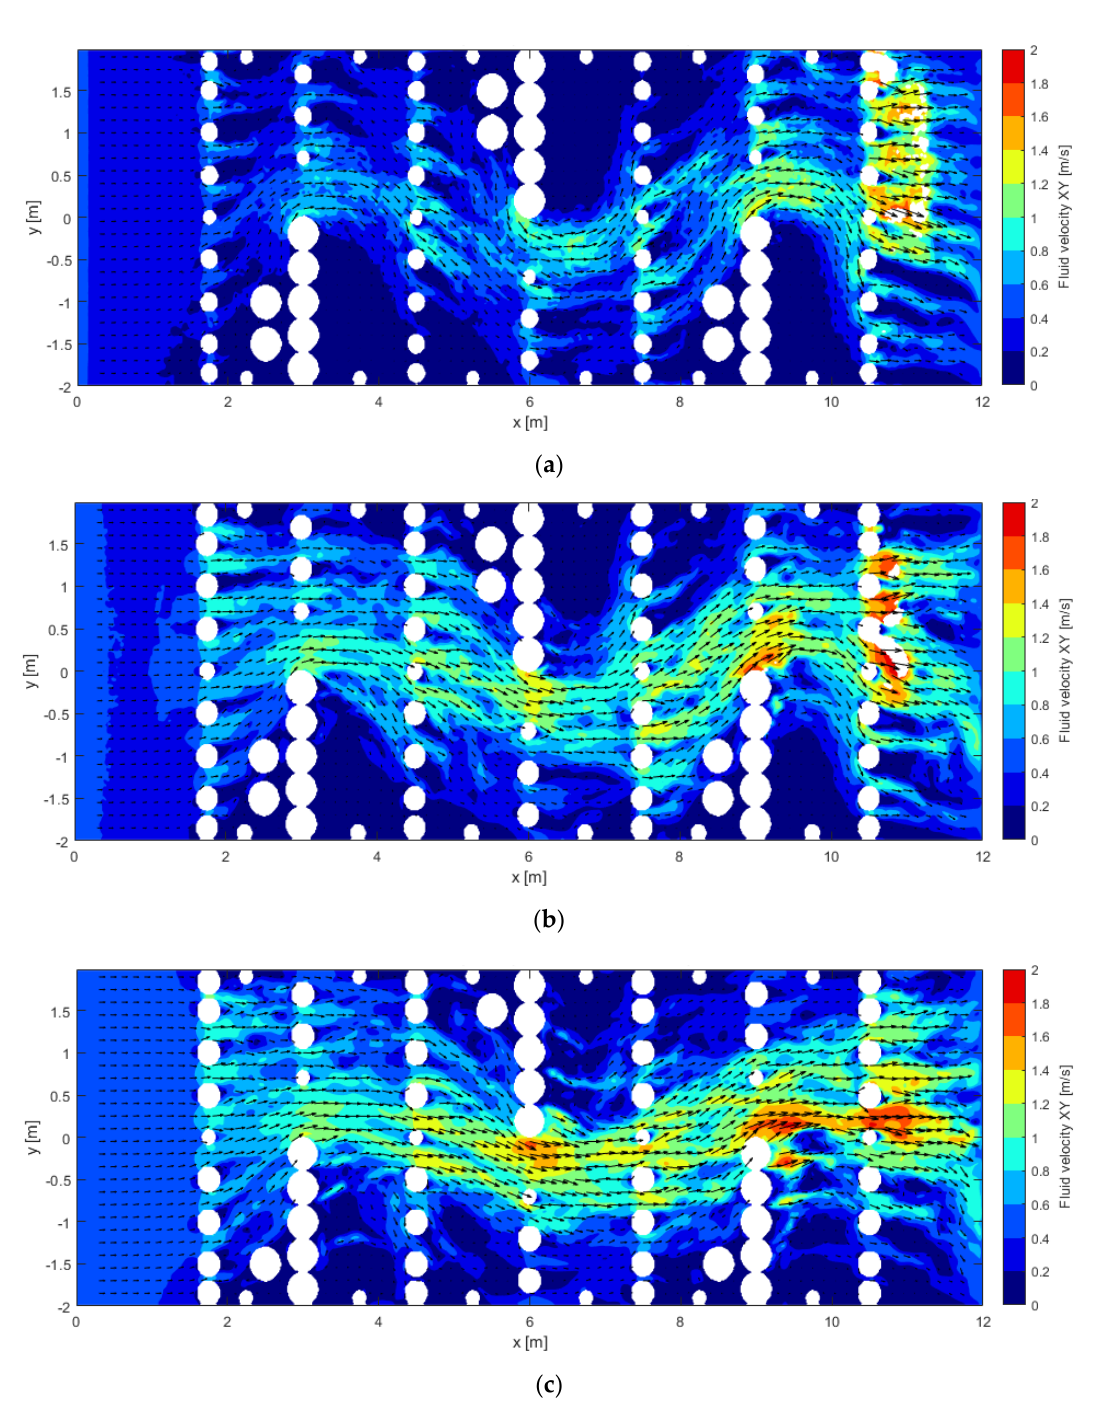
Figure 13. Velocity field at z = H /2 plane after 30 s of simulation. ( a ) Q 1 case, z = 0.05 m; ( b ) Q 2 case, z = 0.10 m; ( c ) Q 3 case, z = 0.15 m.